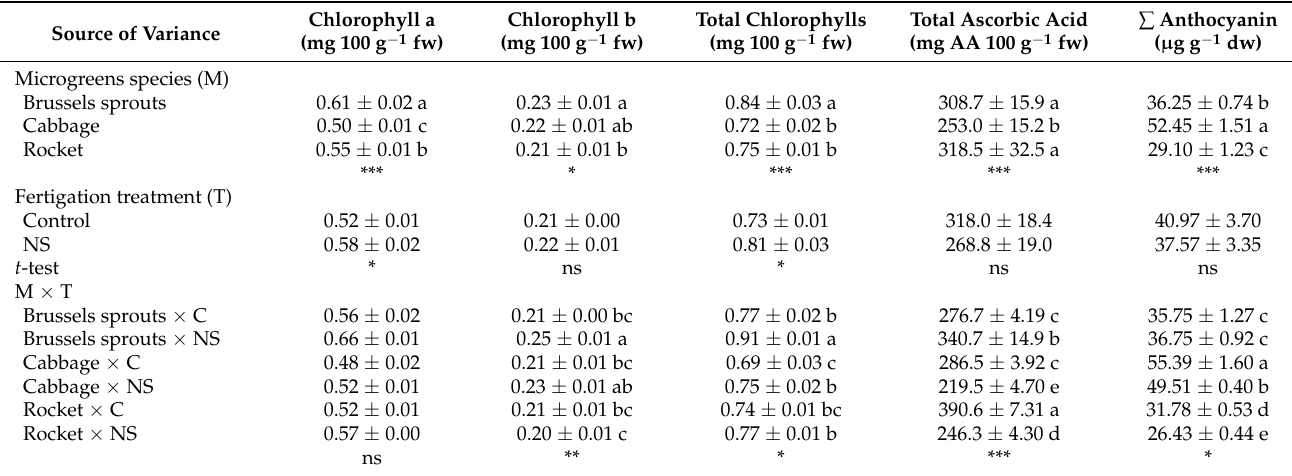
Table 3. Chlorophyll pigment, total ascorbic acid and total anthocyanins of Brussels sprouts, cabbage and rocket microgreens in light of the nutrient solution